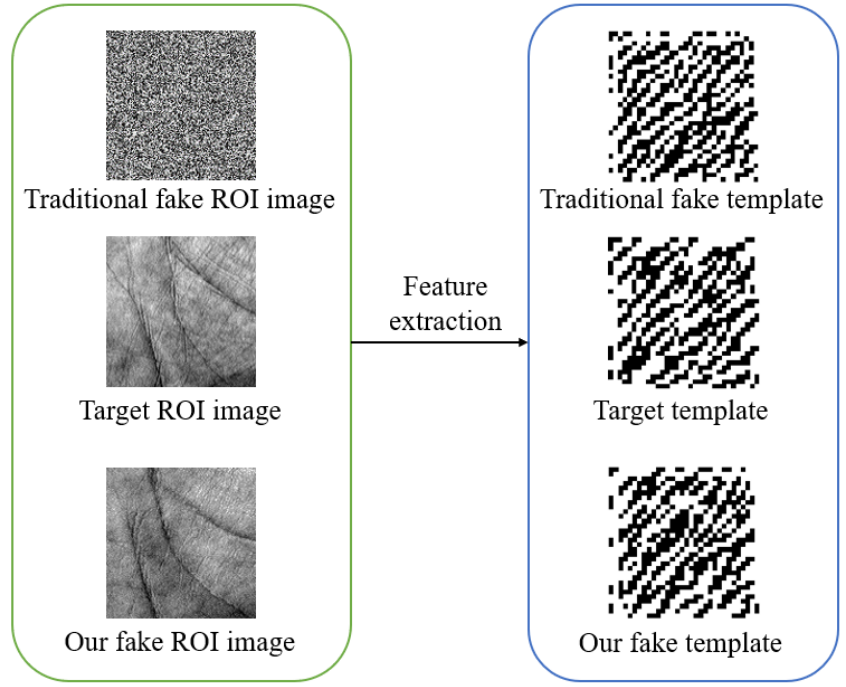
Figure 2. The images and templates in the reconstruction